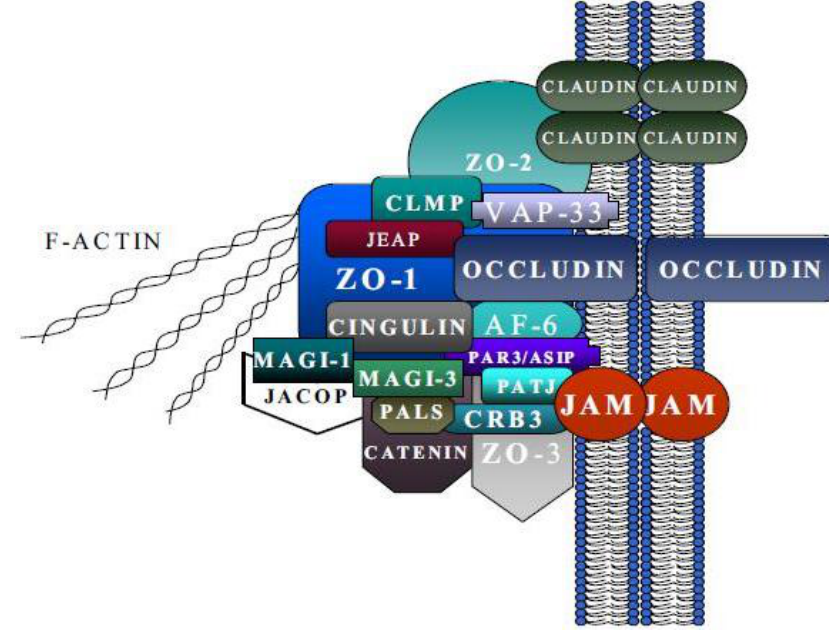
FIGURE 1. Core TJ structure composed of transmembrane proteins, TJ- associated proteins, and scaffolding proteins that fuse the lateral membrane of adjacent cells, restricting solute movement and maintaining polarity. (Reprinted from Maher et al. [2008] Crit. Rev. Ther. Drug Carrier Syst . 25(2), 117–168. Reproduced with kind permission from Begell House, Inc.